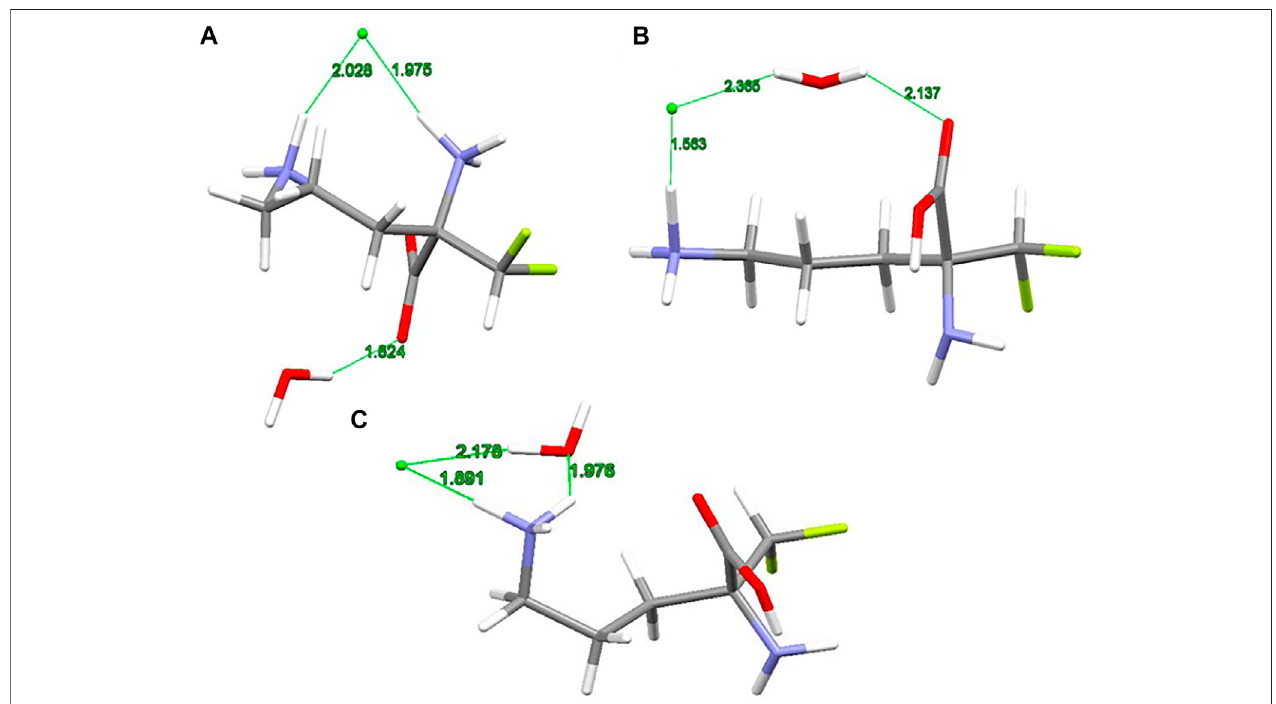
FIGURE 3 | RM06/6-311++G(d,p) optimized structures (A , B and C) of 2-(di fl uoromethyl)ornithine hydrochloride species studied, distances are in Å.